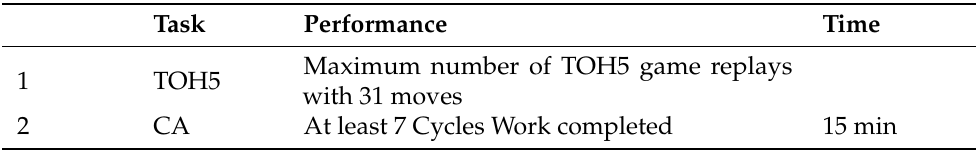
Table A1. Experimental scenario.